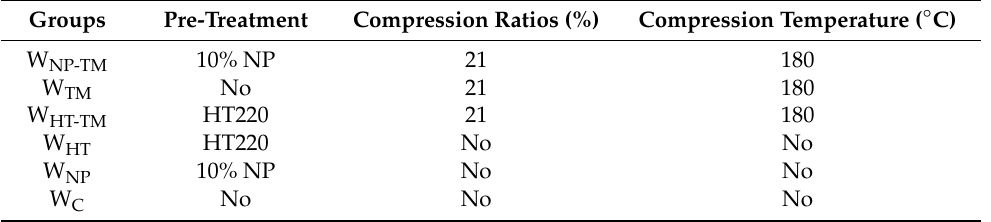
Table 1. Treatment classes and the treatment condition of treated